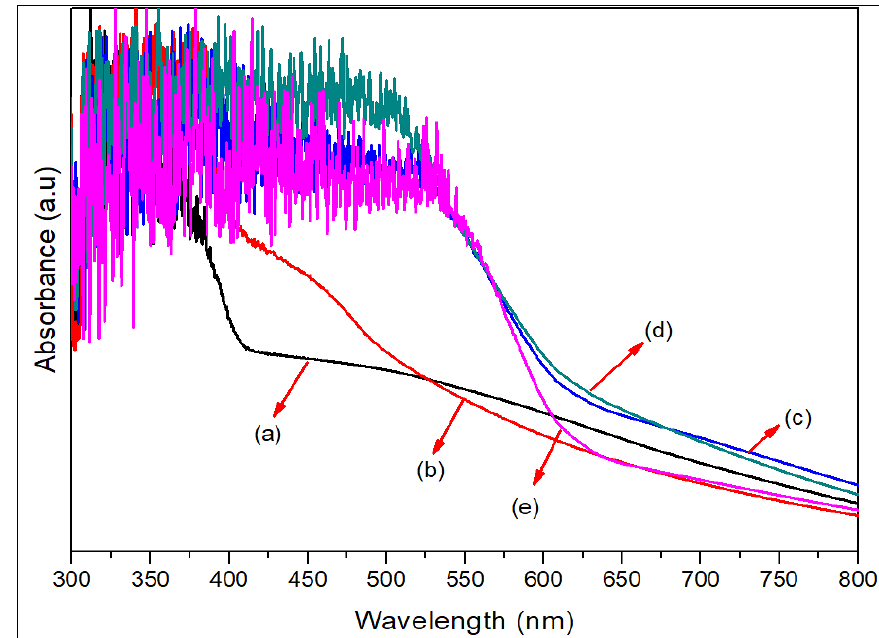
Figure 5. Absorption spectra of (a) TiO 2 sample and Cu 2 O electrodeposition time at (b) 30, (c) 60, (d) 90 and (e) 120